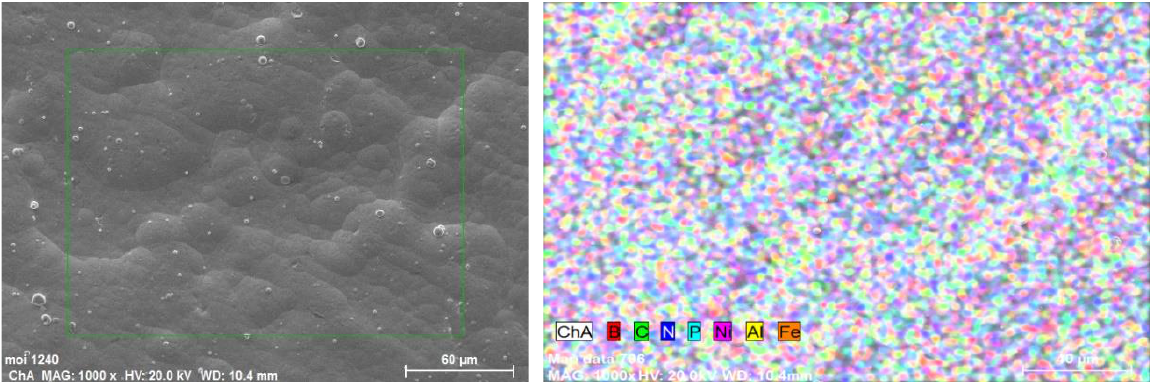
Figure 4. EDS analysis of the marked area on surface of the heat-treated electroless Ni coating with embedded c-BN nanoparticles (Ni-BN HT ).